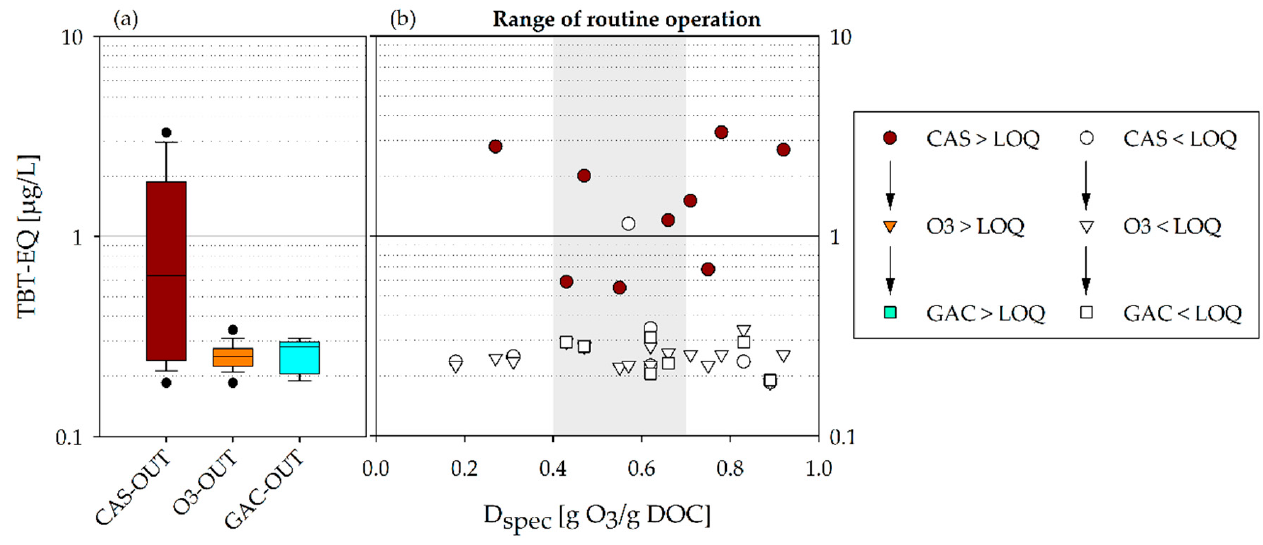
Figure 3. ( a ) Boxplot showing the range of tributyltin acetate equivalents over all campaigns along the multibarrier system; the box indicates the 25th to 75th percentile and the line within the box indicates the median. The whiskers show the 10th and the 90th percentiles and data points that lie outside these percentiles are plotted as dots. ( b ) TBT-EQ along the multibarrier system for each sampling campaign.